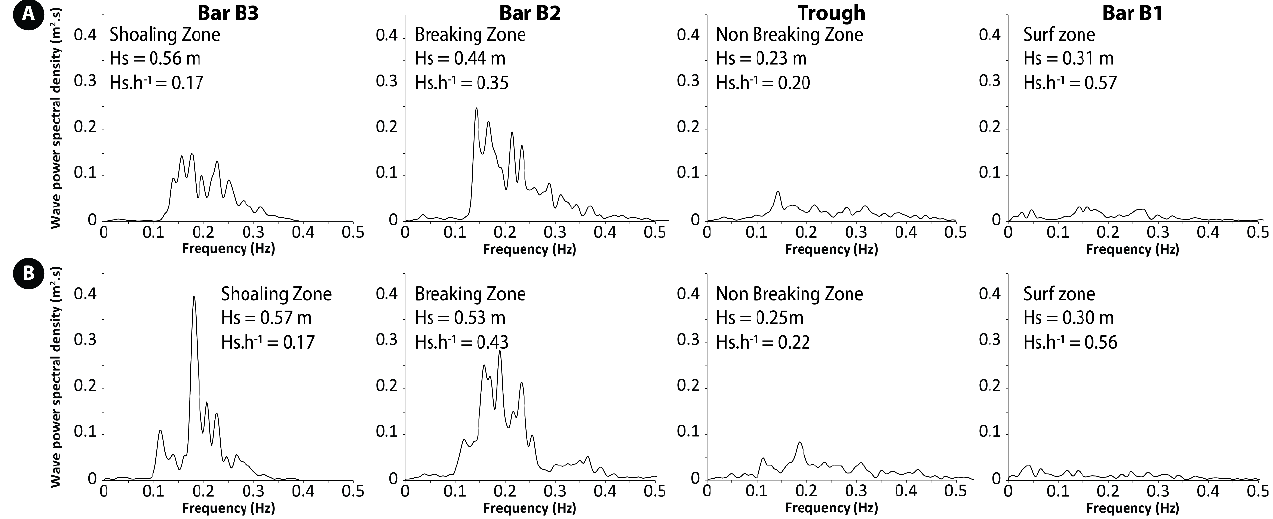
Figure 6. Examples of wave power density spectra computed from wave data obtained at several locations across the intertidal zone on ( A ) 5 June 2013 (12:45 to 12:54 PM, 1 h before high tide) and ( B ) 6 June 2013 (01:45 to 01:54 PM, 1 h 30 min before high tide).